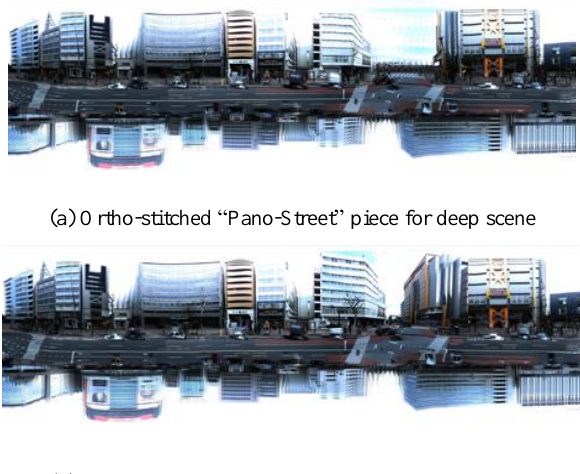
Figure 7. Contradistinction of the ortho-stitched piece and its bridge jointed piece for the deep